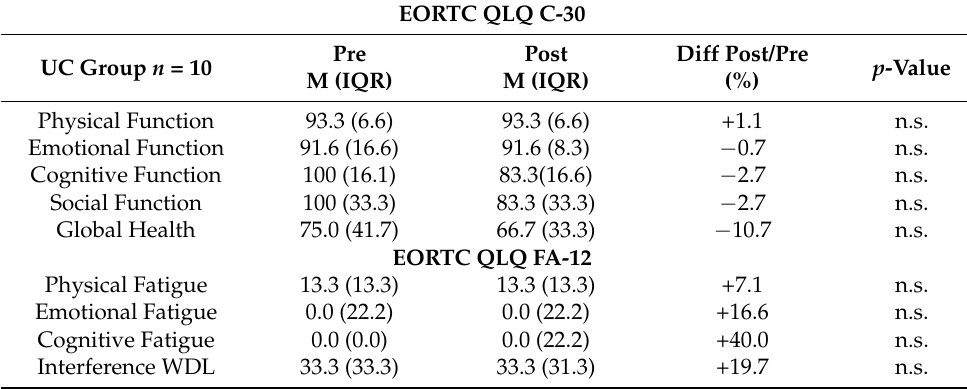
Table 7. Pre- and post-EORTC QLQ C-30 and EORTC QLQ FA-12 analysis—UC Group. Abbreviation: M = Median; IQR = Interquartile Range; Diff = Differences in percentage; n = numbers; WDL = with daily life; n.s. = no statistical